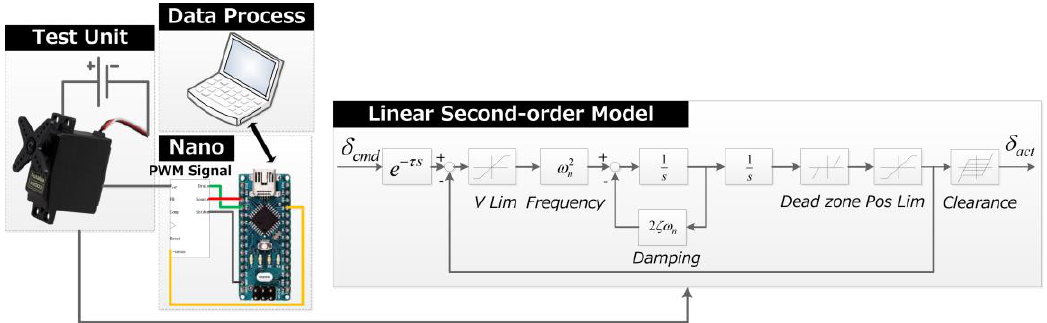
Figure 10. Actuator dynamic performance test experiment scheme.